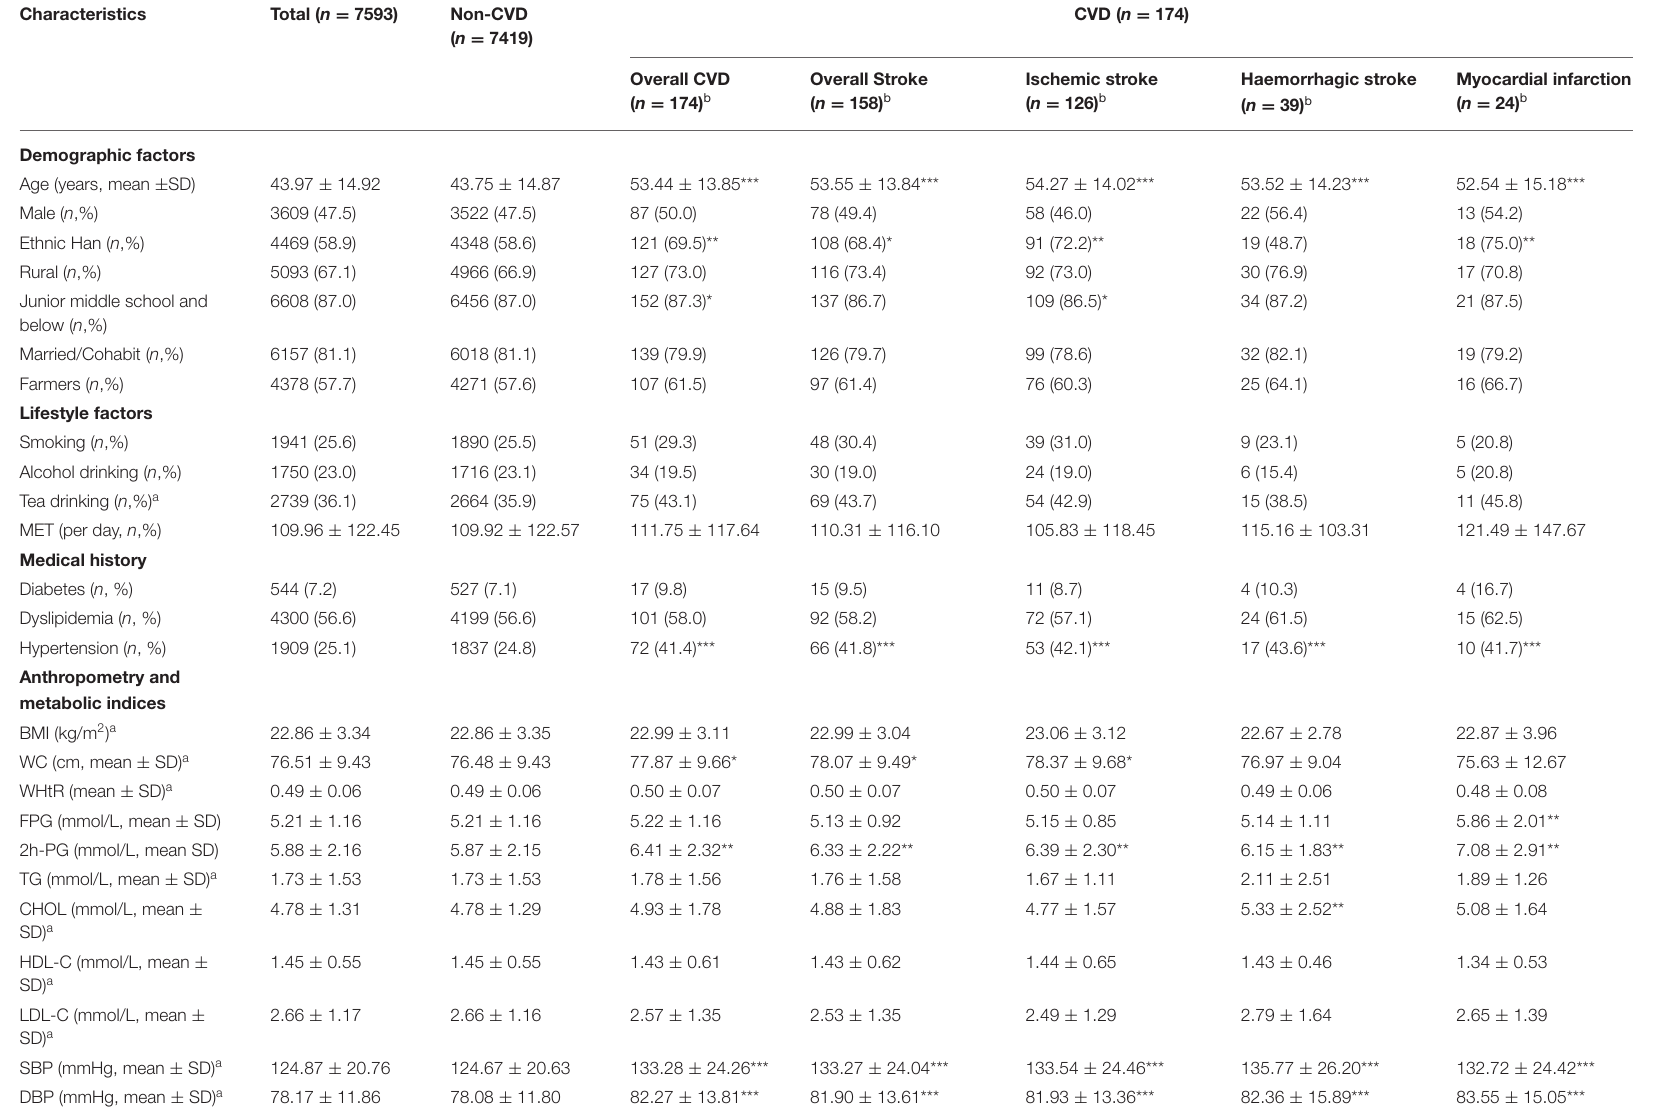
TABLE 1 | Baseline characteristics of participants according to major cardiovascular disease (CVD) onset.